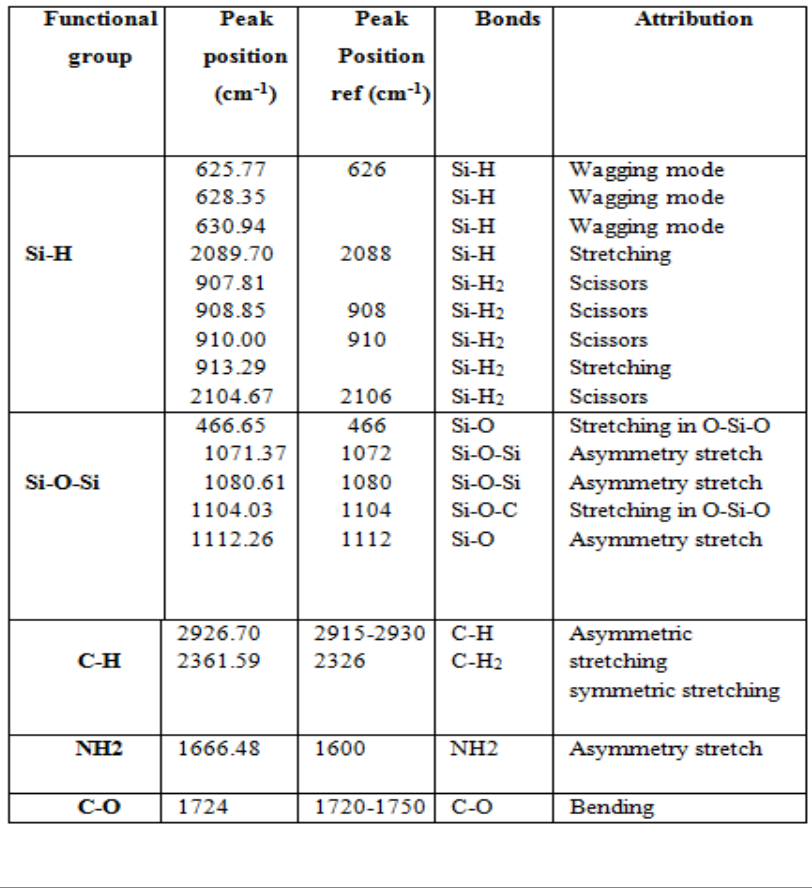
Table 3: Wavenumber positions and attributions of the transmittance peaks observed in PS samples by FTIR measurements.